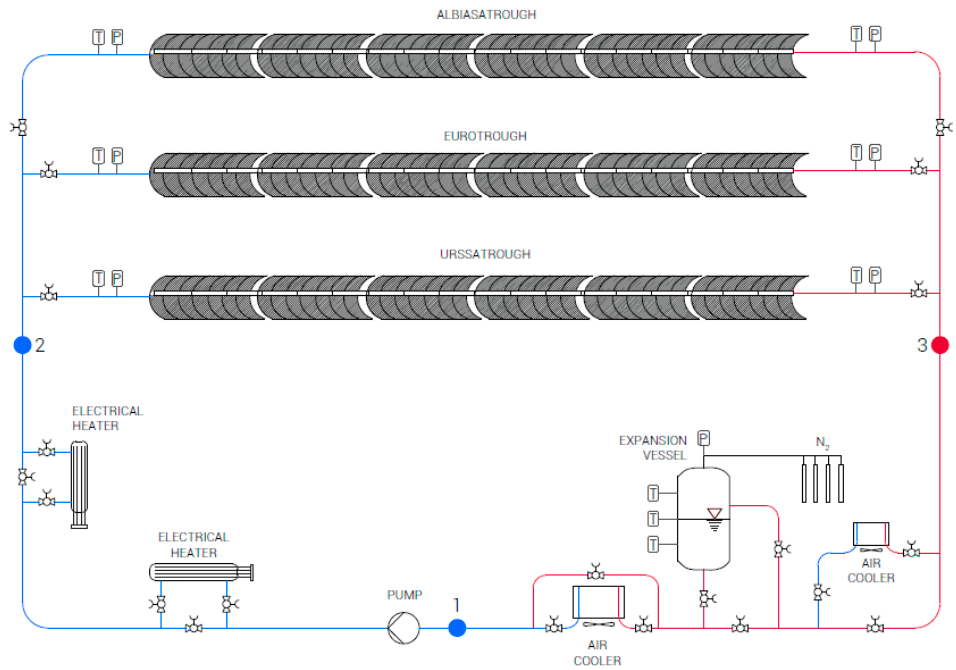
Figure 2. Process flow diagram of the Parabolic Trough Test Loop (PTTL) facilities with the relative sensors and devices position [21].